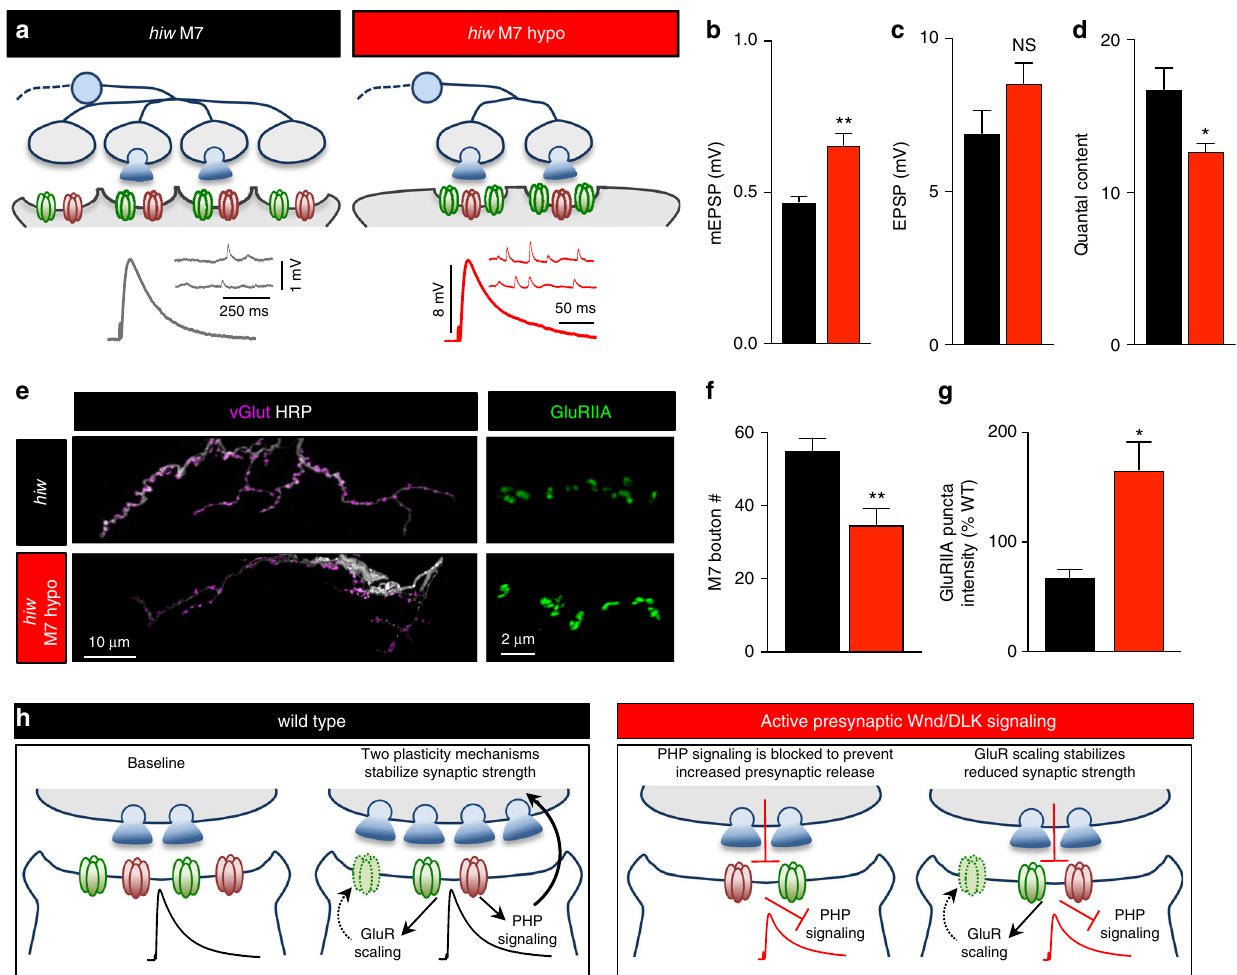
Fig. 9 Homeostatic control of postsynaptic GluR abundance is induced and expressed following hypo-innervation in hiw mutants. a Schematic illustrating a hiw- mutant NMJ and a hypo-innervated hiw -mutant muscle 7 NMJ ( hiw M7 hypo: hiw Δ N ; tubP>stop>Gal4, UAS-FLP, UAS-CD8-GFP/UAS-FasII-PEST + ; H94- Gal4, nSyb-Gal80 ). Representative mEPSP and EPSP traces of the indicated genotypes are shown below. Quanti fi cation of mEPSP amplitude ( b ), EPSP amplitude ( c ), and quantal content ( d ) in the indicated genotypes demonstrates a homeostatic increase in mEPSP amplitude maintains baseline synaptic strength despite a reduction in quantal content in hiw M7 hypo. e Representative images of muscle 7 larval NMJs in hiw and hiw M7 hypo immunostained with antibodies that recognize vGlut and the neuronal membrane (HRP). Note the reduced innervation of boutons onto muscle 7 in the hiw M7 hypo condition. Right: Representative GluRIIA staining of the indicated genotypes. An upregulation in GluRIIA levels is observed speci fi cally on hiw M7 hypo NMJs. Quanti fi cation of bouton numbers ( f ) and GluRIIA puncta intensity ( g ) in the indicated genotypes. h Schematic illustrating injury-related adaptations to synaptic function and homeostatic plasticity. Activation of presynaptic DLK signaling induces a reduction in GluR levels. This diminished state of synaptic strength is achieved through a silencing of PHP signaling upstream of Tor activity, and stabilized by GluR scaling. Error bars indicate ± SEM followed by an unpaired t -test. * p ≤ 0.05; ** p 0.01; NS not signi fi cant, p >